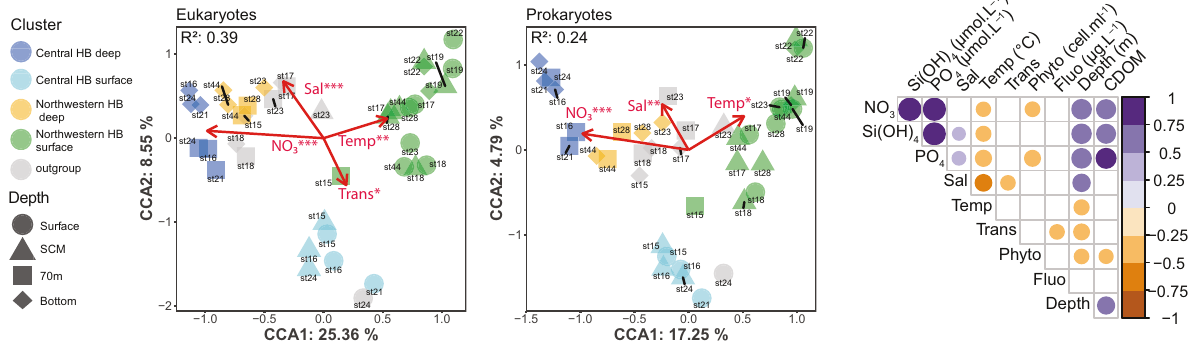
Fig. 3 Ordination plots of distance-based redundancy analysis (db-RDA) and Pearson correlation between environmental variables of the stations. Microbial eukaryotes (left panel) and prokaryotes (central panel) communities. Only statistically signi fi cant environmental variables are shown. Symbol colors were de fi ned according to the clusters identi fi ed in the hierarchical Bray – Curtis analysis from Fig. 2. Symbols indicate depth category. The right panel shows signi fi cant correlations between variables. Transmission abbreviated to “ Trans ” is a measure of the fraction of light that is absorbed or